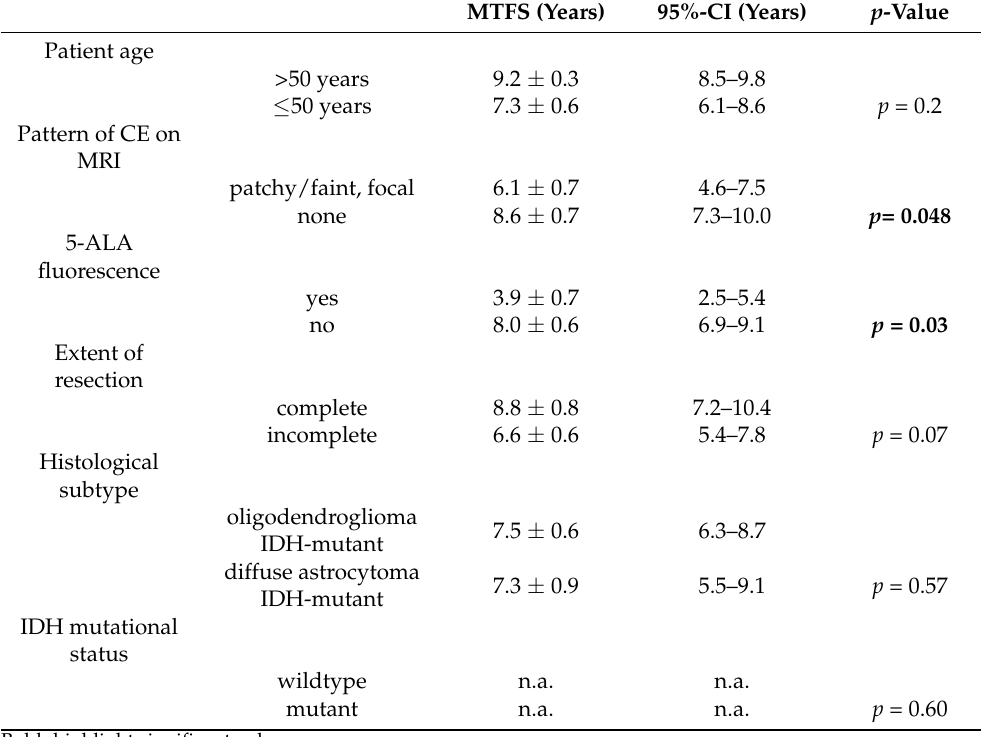
Table 3. Malignant transformation-free survival.